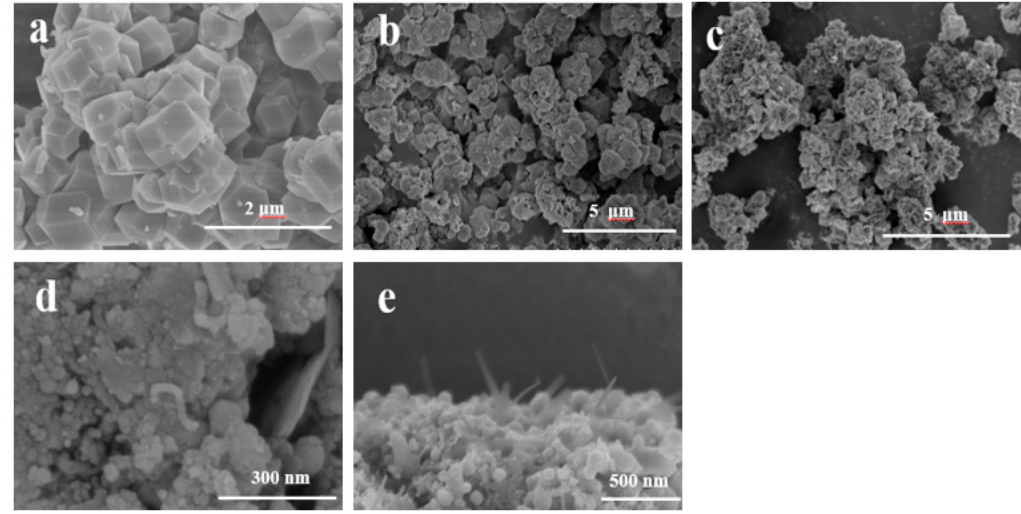
Figure 2. SEM images of ( a ) ZIF-67; ( b ) FeCo/NC-400; ( c ) FeCo/NC-500; ( d ) FeCo/NC-600; and ( e ) FeCo/NC-700.